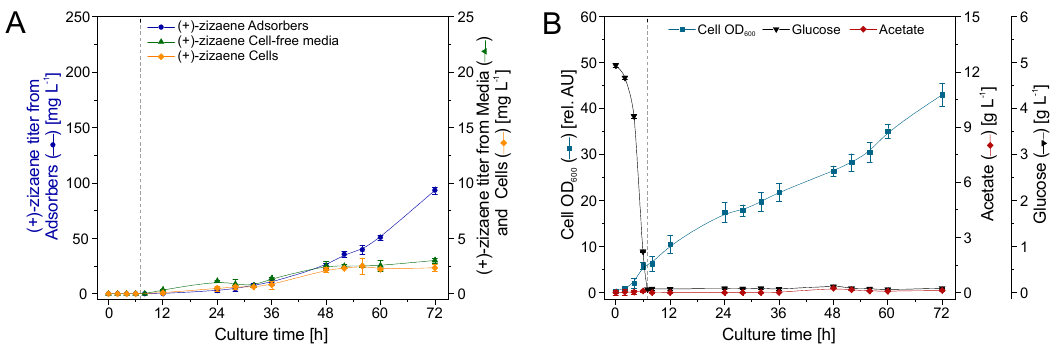
Figure 7. Production of (+)-zizaene ( A ) and growth kinetics ( B ) in 2 L bioreactor with external recovery configuration (ERC). Dotted line indicates division between batch and fed-batch stages.